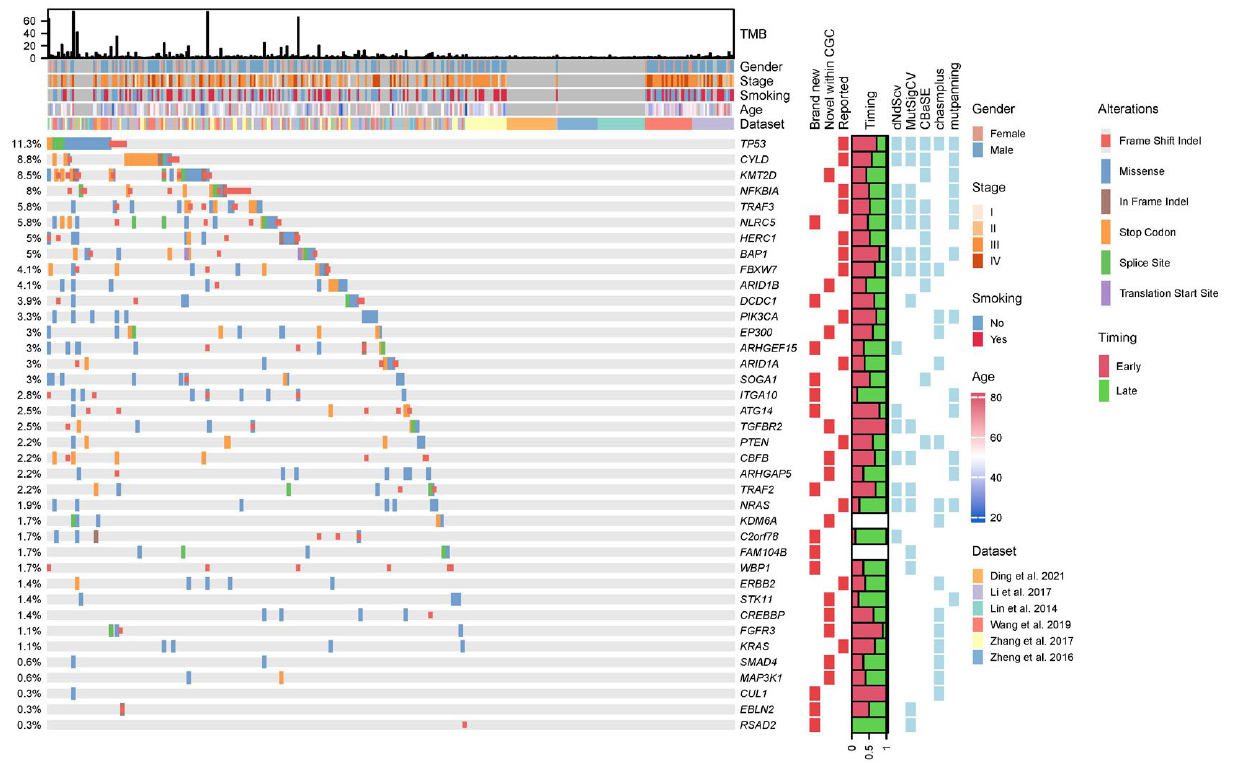
Figure 1. Driver landscape of the NPC cohort. Oncoprint plot of the driver landscape across the patients. The top panel shows the tumor mutation burden (TMB) of the patients. The patient cohort was plotted below the TMB panel. Driver frequencies are shown on the ( left ). Drivers’ status (whether it is reported in the literature (“reported”) or newly identified but within CGC (“novel within CGC”) or brand new), proportion of time being early or late mutations and statistical methods with significant results as driver genes were plotted on the ( right ).